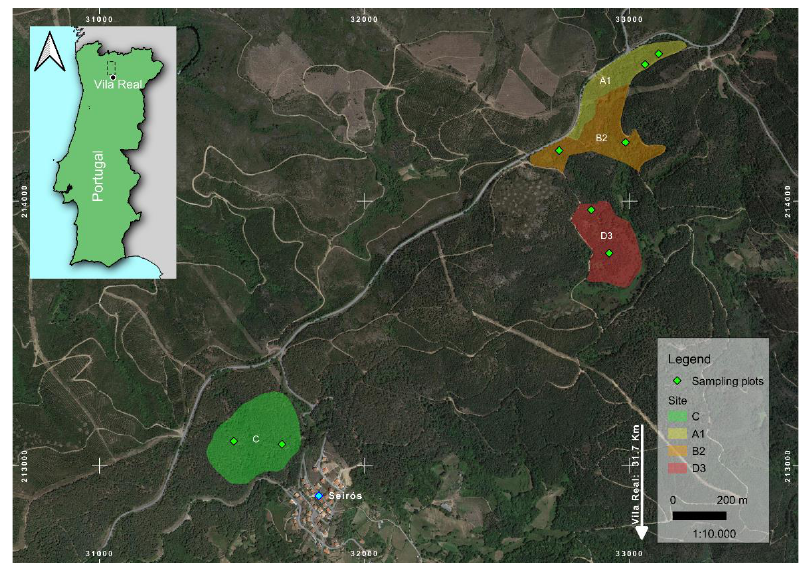
Figure 1. Geographic location of the study area. Table 1. Total area of stands and years of occurrence of fires.